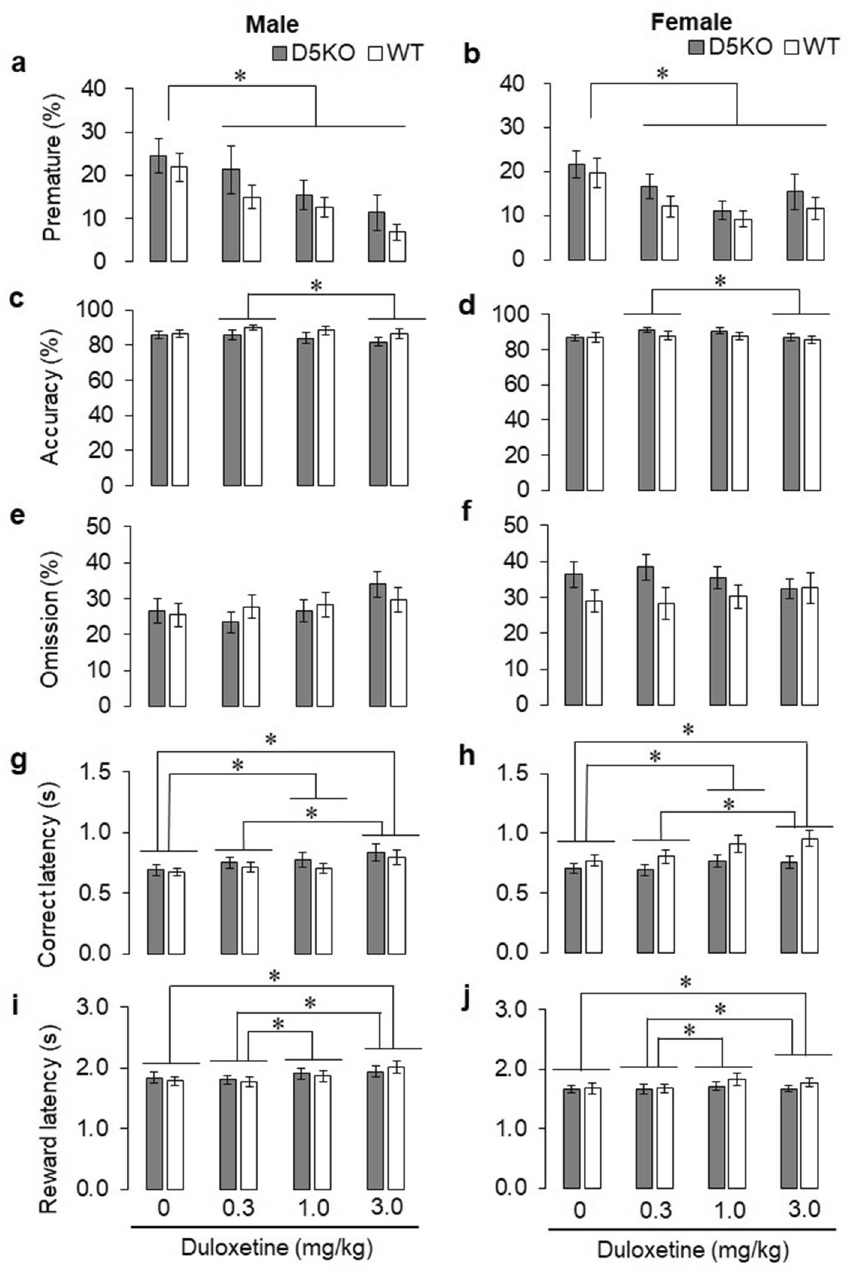
Figure 5. Effects of acute duloxetine administration on impulsive action. ( a ) The percentage of premature responses, a measure of impulsive action, of male D5KO mice and their WT littermates. ( b ) The percentage of premature responses, a measure of impulsive action, of female D5KO mice and their WT littermates. ( c ) Accuracy, the percentage of correct responses of male D5KO mice and their WT littermates. ( d ) Accuracy, the percentage of correct responses of female D5KO mice and their WT littermates. ( e ) The percentage of omissions of male D5KO mice and their WT littermates. ( f ) The percentage of omissions of female D5KO mice and their WT littermates. ( g ) The mean correct response latency (s) of male D5KO mice and their WT littermates. ( h ) The mean correct response latency (s) of female D5KO mice and their WT littermates. ( i ) The mean reward response latency (s) of male D5KO mice and their WT littermates. ( j ) The mean reward response latency (s) of female D5KO mice and their WT littermates. The black bars indicate D5KO mice and white bars indicate WT littermates. The data are presented as the means ± SEM. * p <